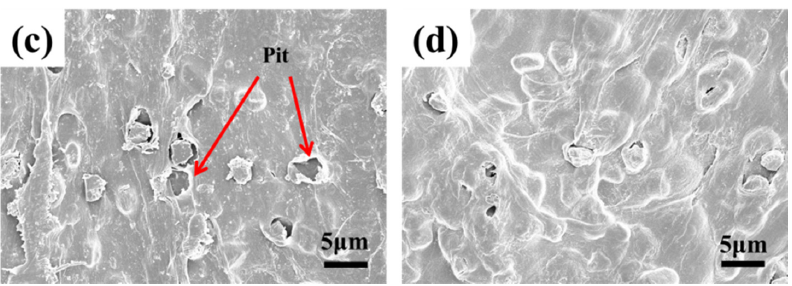
Figure 5. Combination of diamond ( a , c ) and hybrid ( b , d ) abrasives with the matrix before ( a , b ) and after ( c , d ) polishing.